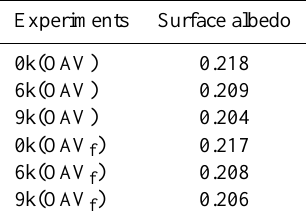
Table 4. Summer (JJAS) surface albedo values in the early and mid-